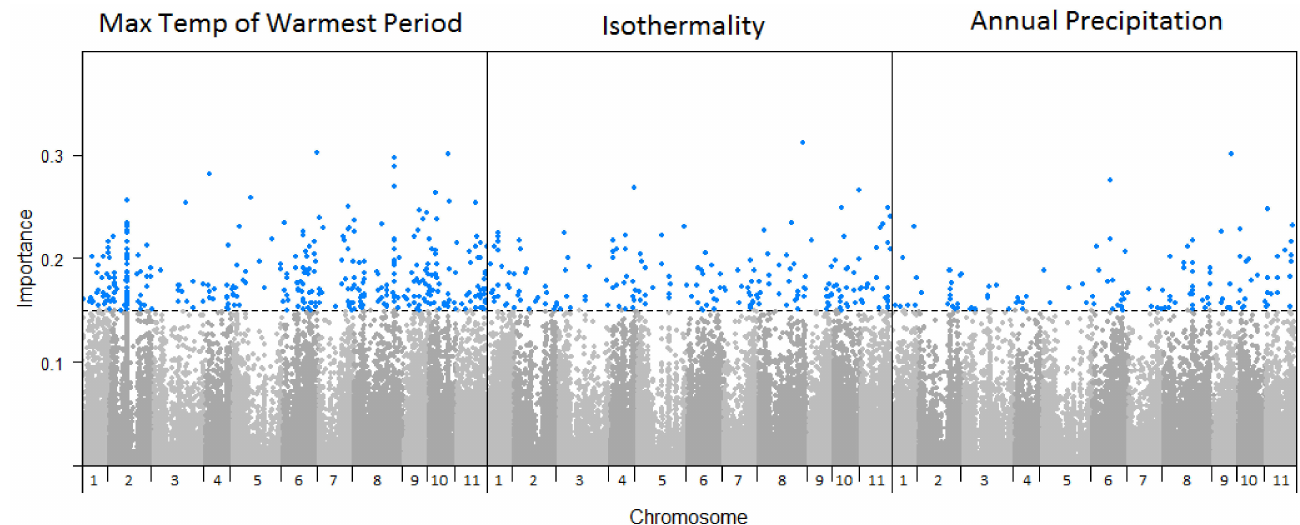
Figure 3. Manhattan plots of SNP importance for maximum temperature of the warmest period, isothermality, and annual precipitation across the 11 Eucalyptus globulus chromosomes. Each of the 71,183 SNPs are shown (points) across the 11 chromosomes, where the blue points correspond to those associated with the climate variable above the 0.15 cumulative importance